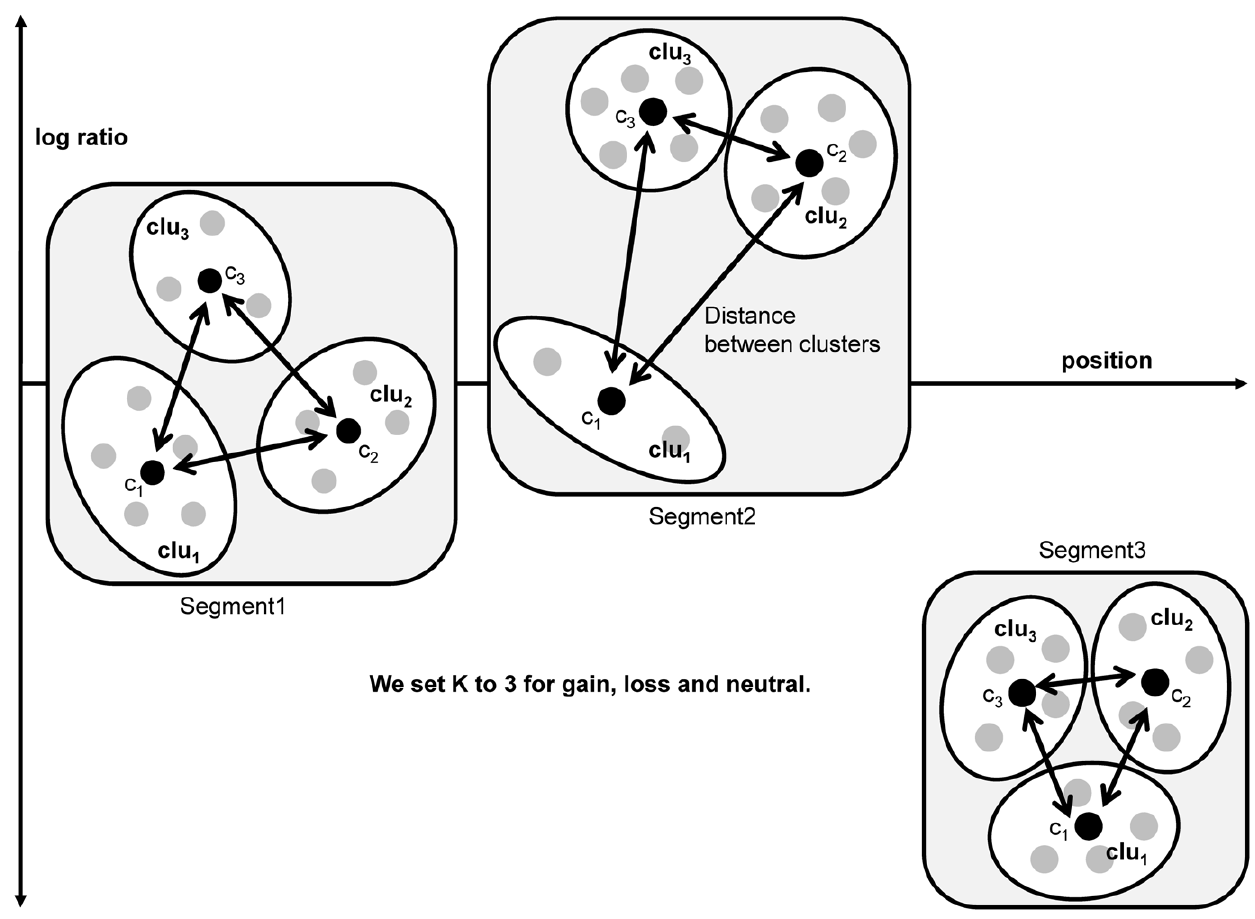
Figure 10. Three possible distributions of clusters. It would be problematic to just consider the distances between clusters. The gray circle indicates the objects in a cluster, and the black circle indicates the centroid of a cluster. This is a conceptual figure to explain the various relationships among clusters. doi:10.1371/journal.pone.0026975.g010 PLoS ONE |